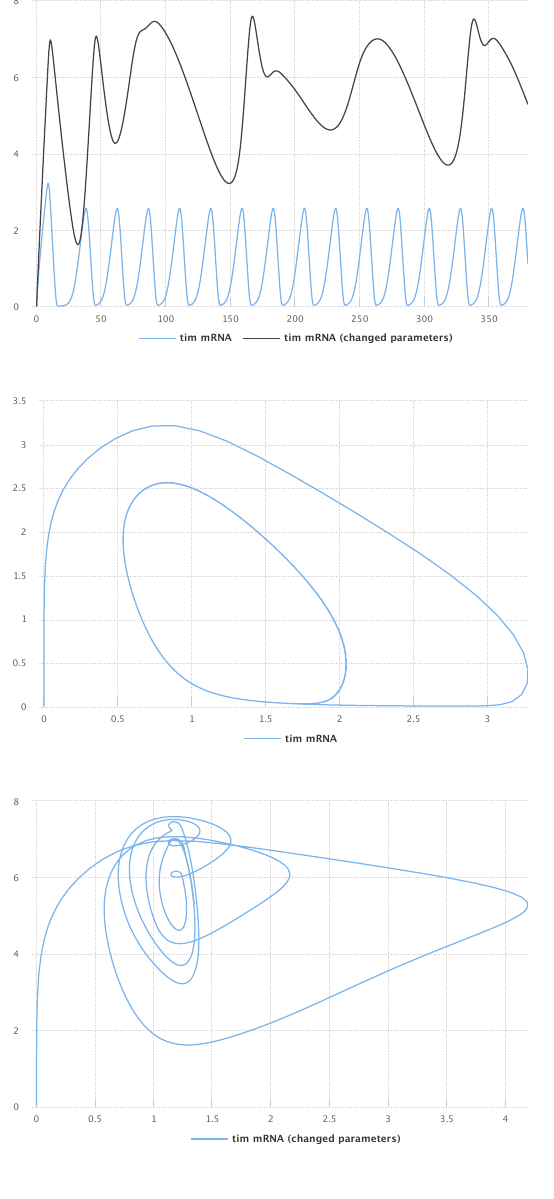
Figure A.17: The simulation result gained from the simulation description given in Listing A.10. Simulation with SED-ML web tools [2].